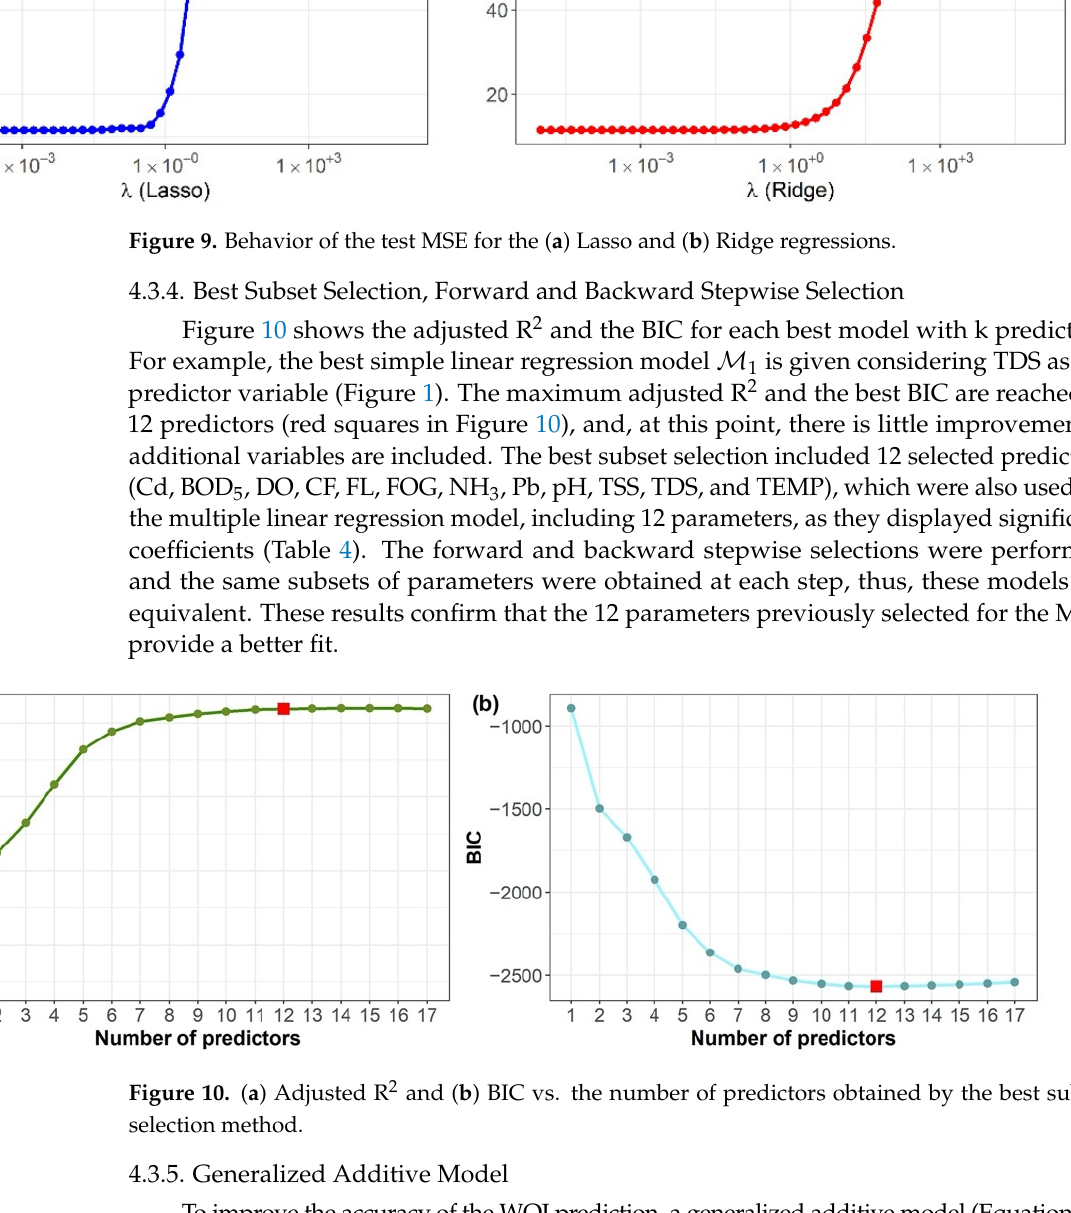
15 of 24 Figure 8. Residuals and fitted values of the multiple linear regression model using 12 parameters.